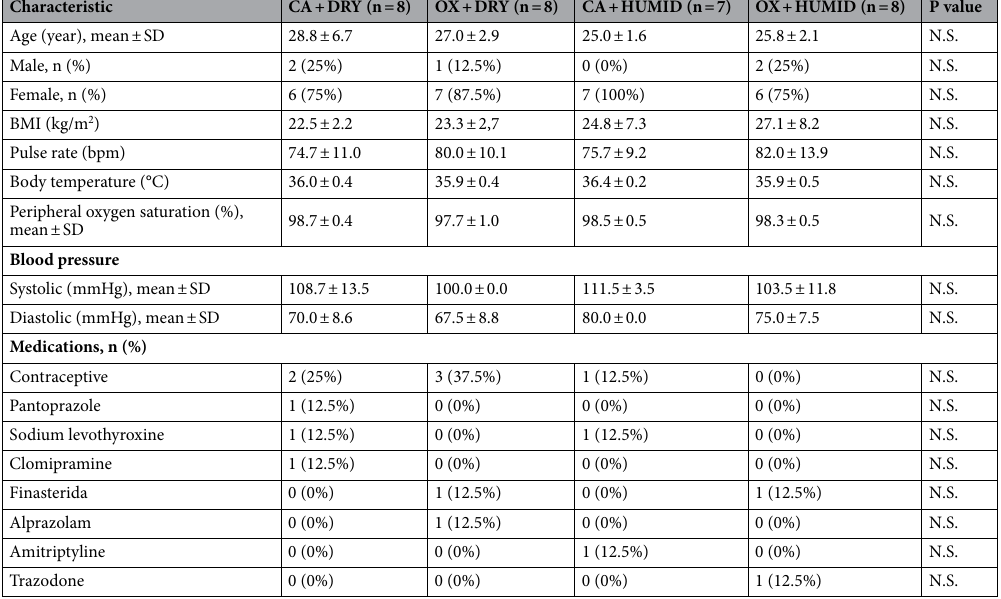
Table 1. Characteristics of